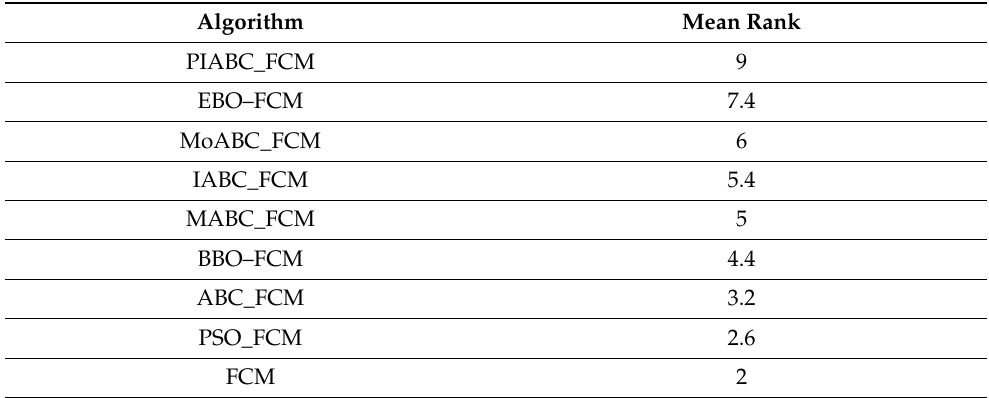
Table 9. Friedman Test based on PC validity index—result for natural images.